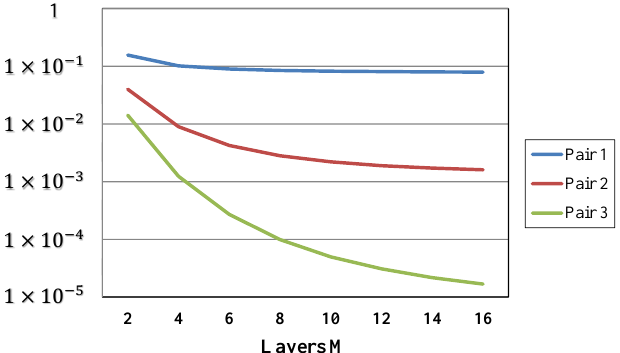
= J ( e opt ) of the cost functional i i